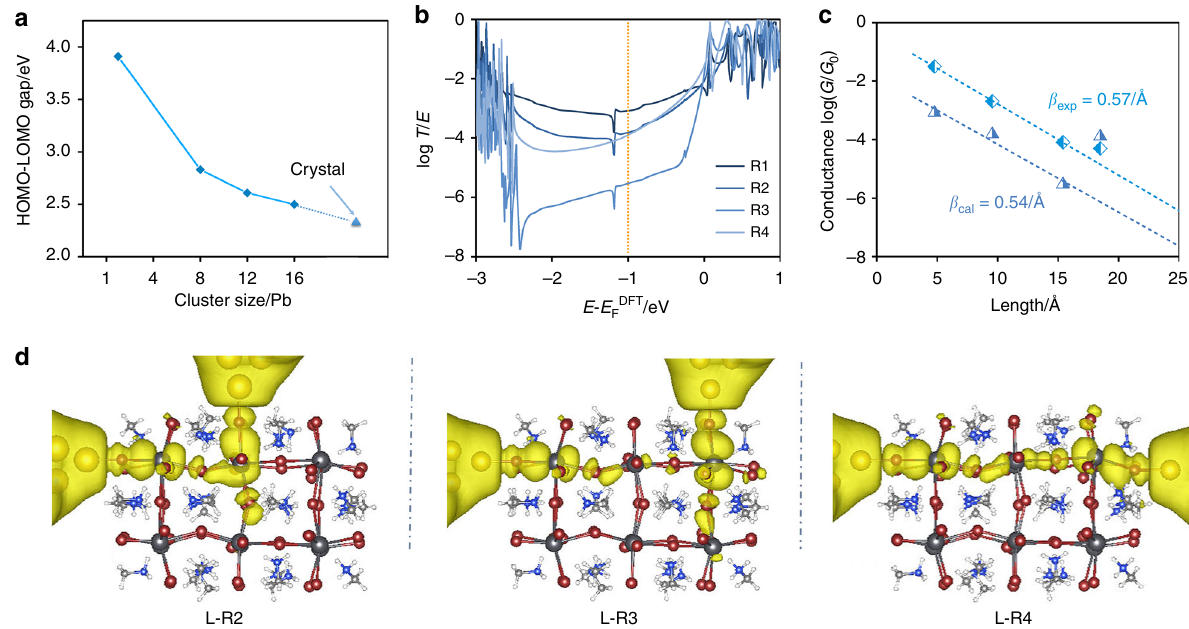
Fig. 4 The charge transport property of 12Pb MAPbBr 3 with different connectivities. a HOMO-LUMO gaps with respect to the size of MAPbBr 3 clusters. . c The corresponding experimental and theoretical conductance evolution b The transmission spectra of different connectivities as the function of E (cid:2) E DFT F versus the increasing separation between the two electrodes. The theoretical dots stand for the room-temperature conductance derived from the transmission spectra in (b) at -1 eV while the corresponding dashed lines show the corresponding linear fi t to ln G ¼ (cid:2) β L þ constant , where L is the separation between two Br atoms. d The LDOS with yellow color in the energy window from – 1.5 eV to -0.5 eV for ‘ L-R2 ’ ‘ L-R3 ’ and ‘ L-R4 ’ separately at the isosurface